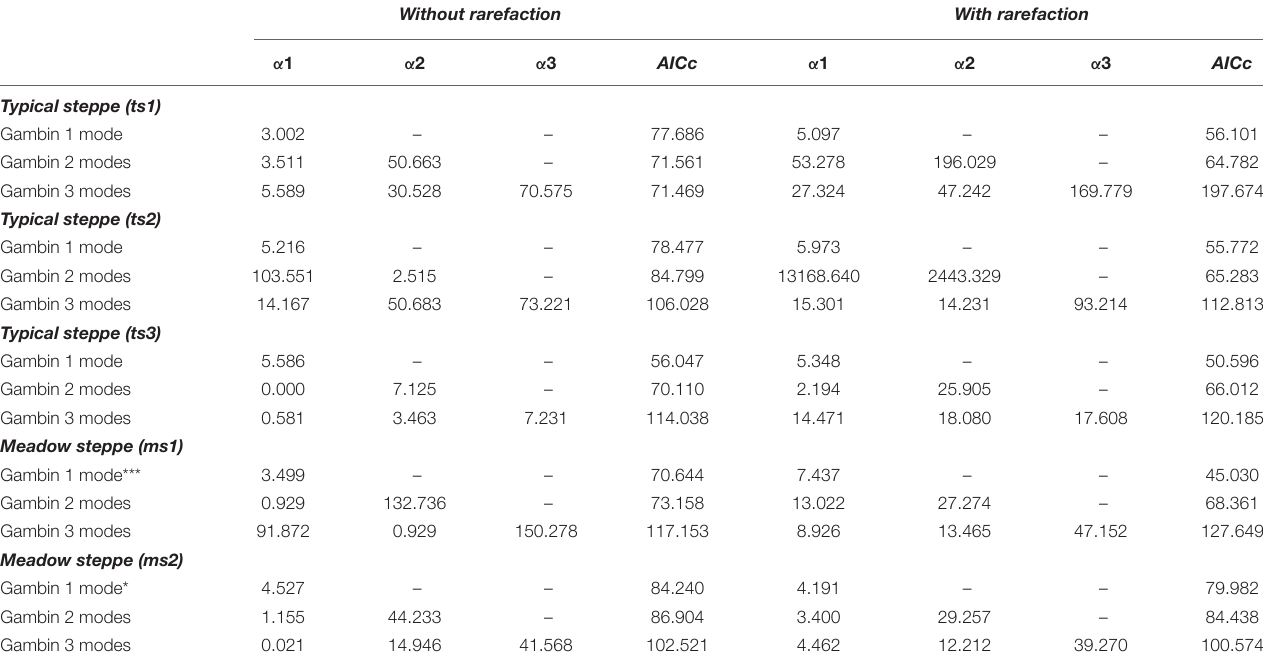
TABLE 5 | Values of gambin α and model’s corrected Akaike Information Criterion (AICc) for species abundance distributions of carabid beetles in various types of Chinese steppes. Without